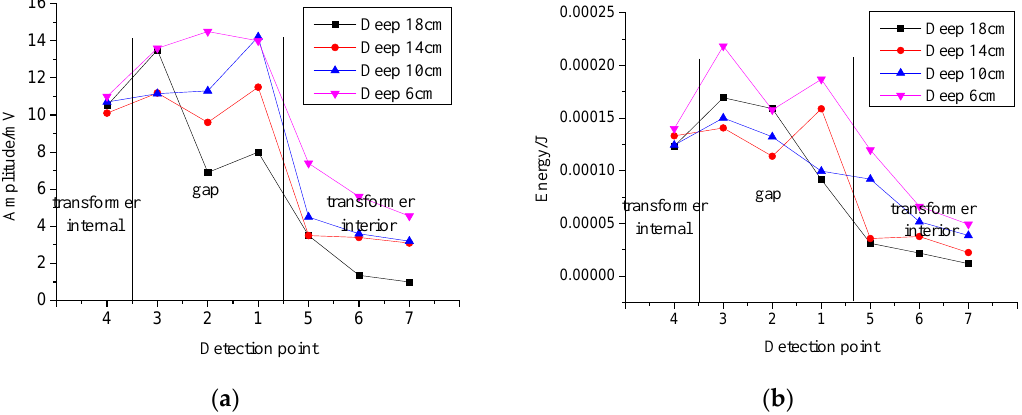
Figure 20. Distributions of PD electromagnetic signals in different depth gaps in experiment: ( a ) Amplitude distribution; ( b ) Cumulative energy distribution.